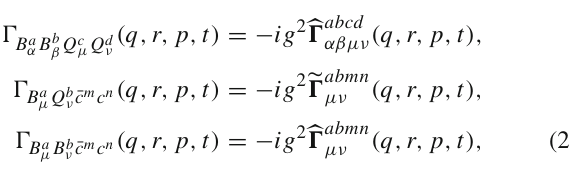
These vertices will be denoted